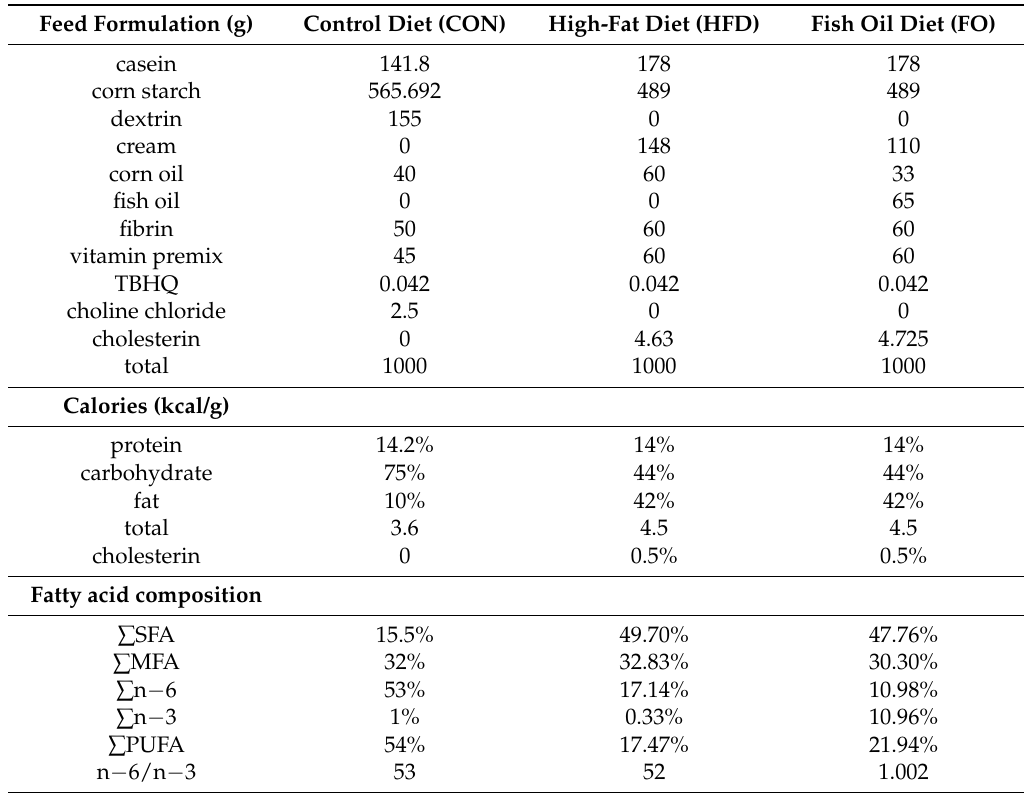
Table 1. Feed formulation, feed energy constitute and the total fatty acids profile of experimental